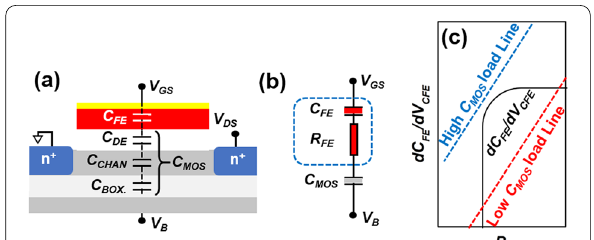
Fig. 4 ( a ) Capacitance in FE ETSOI MOSFET. ( b ) Equivalent circuit model of DE–FE network according to Miller model. ( c ) Graphical representation of the equation with respect to P for different values of C MOS